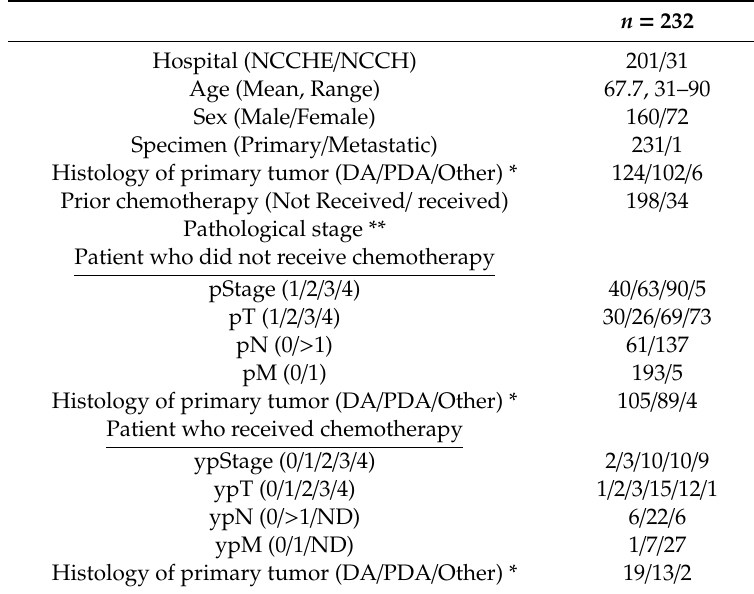
Table 2. Patient Characteristics of only surgical